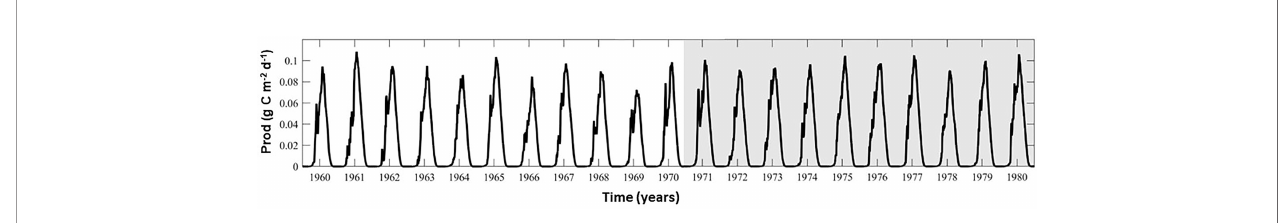
FIGURE 2 | Regionally averaged seasonal cycle of total primary production (diatoms and small phytoplankton) for the Kara Sea coastal region. The shaded region indicates the last ten years that were used in model analysis